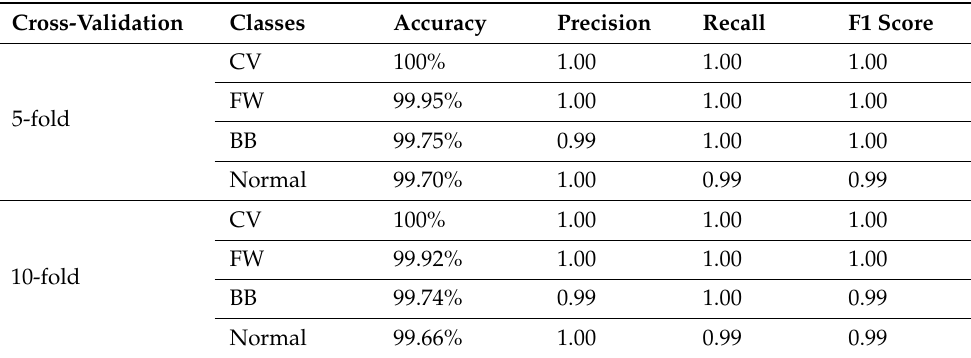
Table 4. Multi-classification of cotton leaf infection.